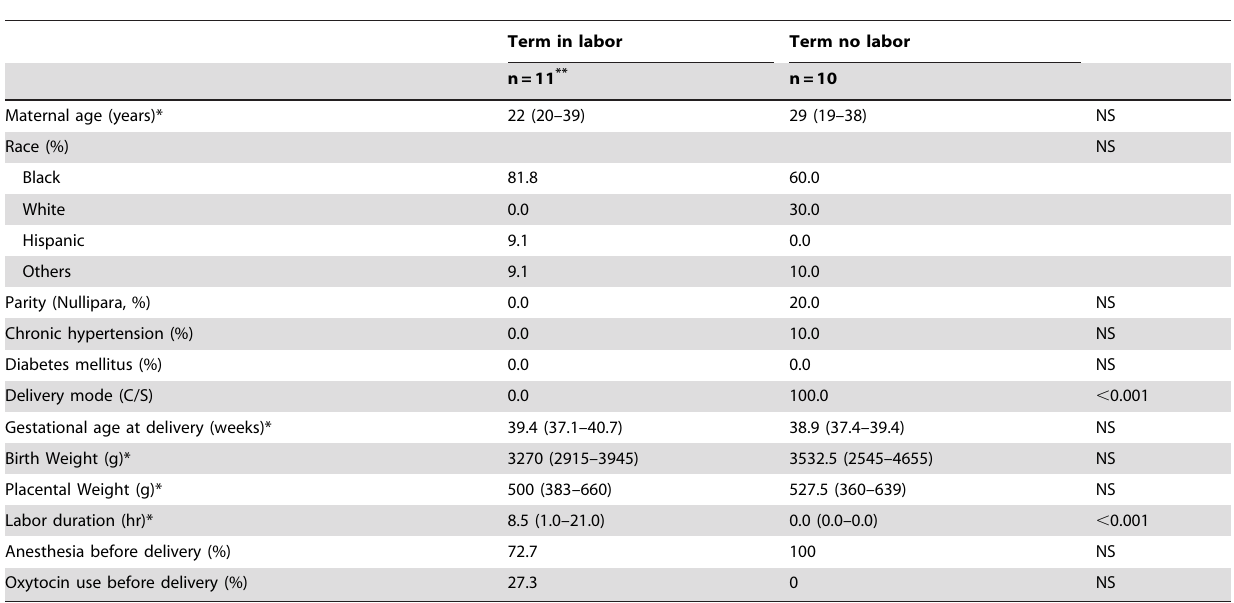
Table 1. Patient demographics and clinical information of cases used for microarray and confirmation